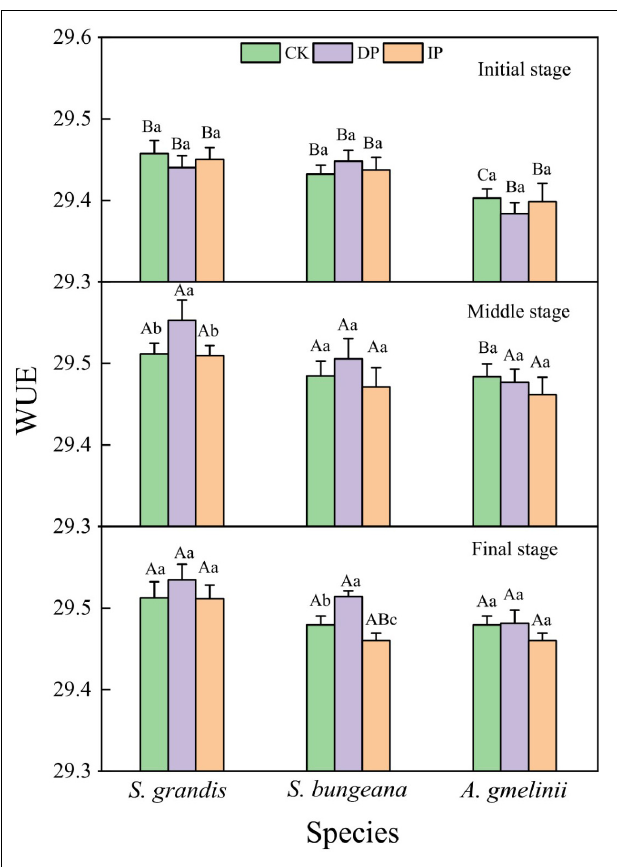
FIGURE 2 | Response of plant WUE to precipitation manipulation at different growth stages. CK, ambient precipitation; DP, decrease precipitation (–50%); IP, increase precipitation (+50%); WUE, water use efficiency. Different small letters mean significant difference among different treatments at the 0.05 level; different capital letters mean significant difference among different growing stages at the 0.05